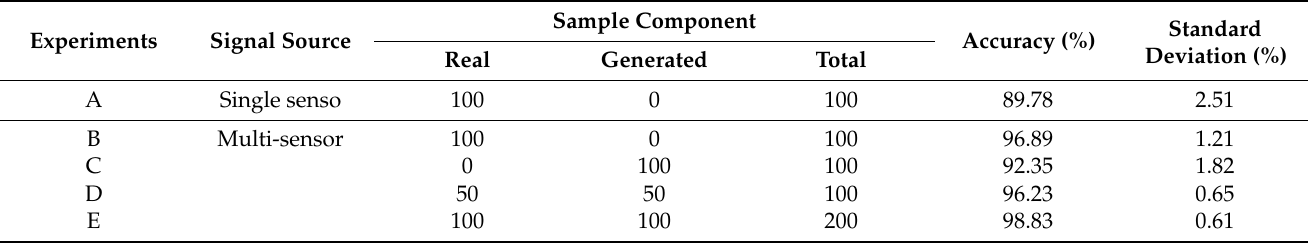
Table 1. Experimental setup and results for evaluation of the generated